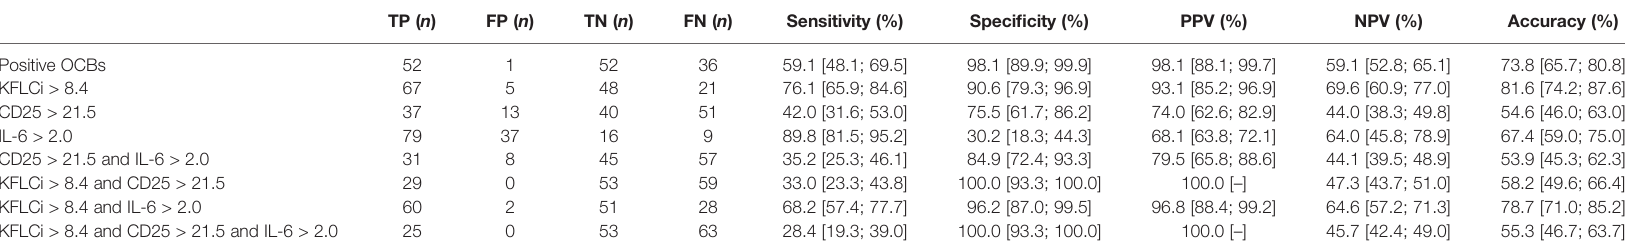
TABLE 3 | Diagnostic performance of the different biomarkers comparing MSARD to NIND ( n = 141).